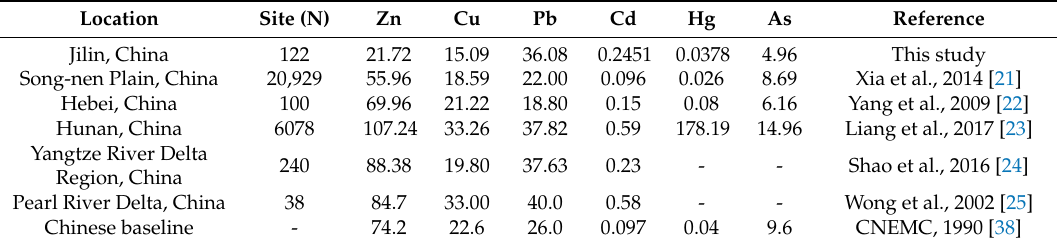
Table 2. Average concentrations of toxic elements in soil from different